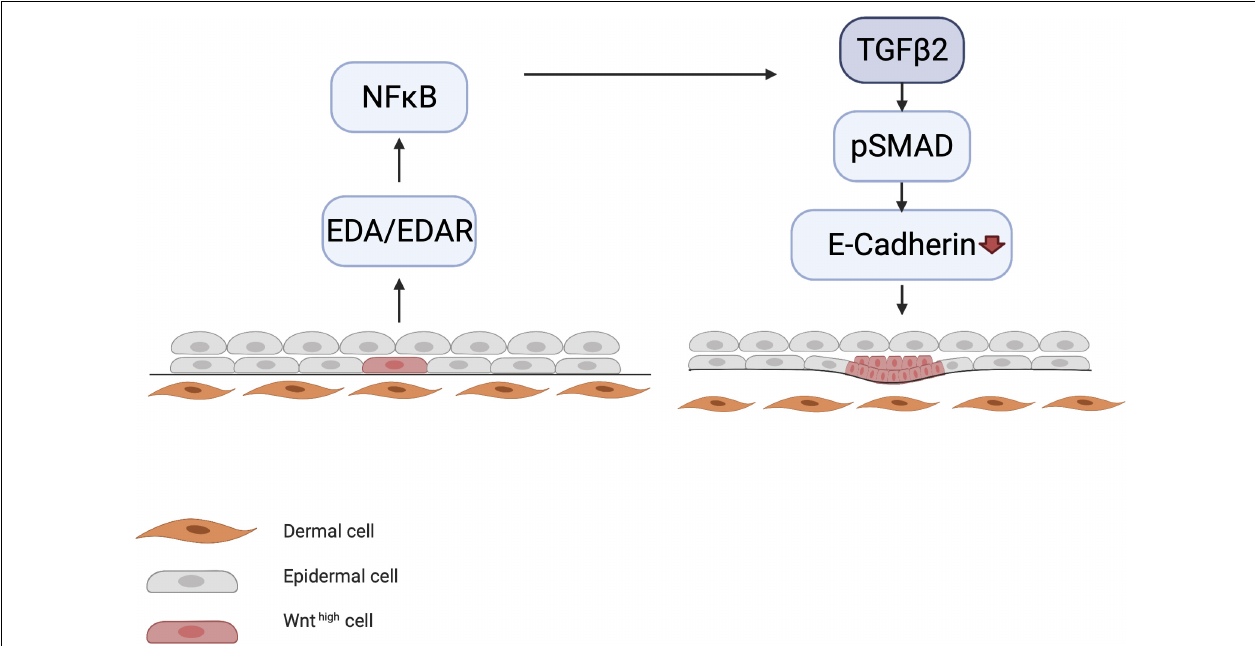
FIGURE 3 | Downregulation of E-cadherin. EDA/EDAR signaling is downstream of epithelial WNT activation. EDA/EDAR signaling activates NF- κ B, which in turn leads to the production of TGF- β 2 by an as yet unknown mechanism. During the induction phase, TGF- β 2 downregulates E-cadherin via the pSMAD pathway. E-cadherin downregulation leads to the migration of epidermal cells, which is a prerequisite for placode formation.